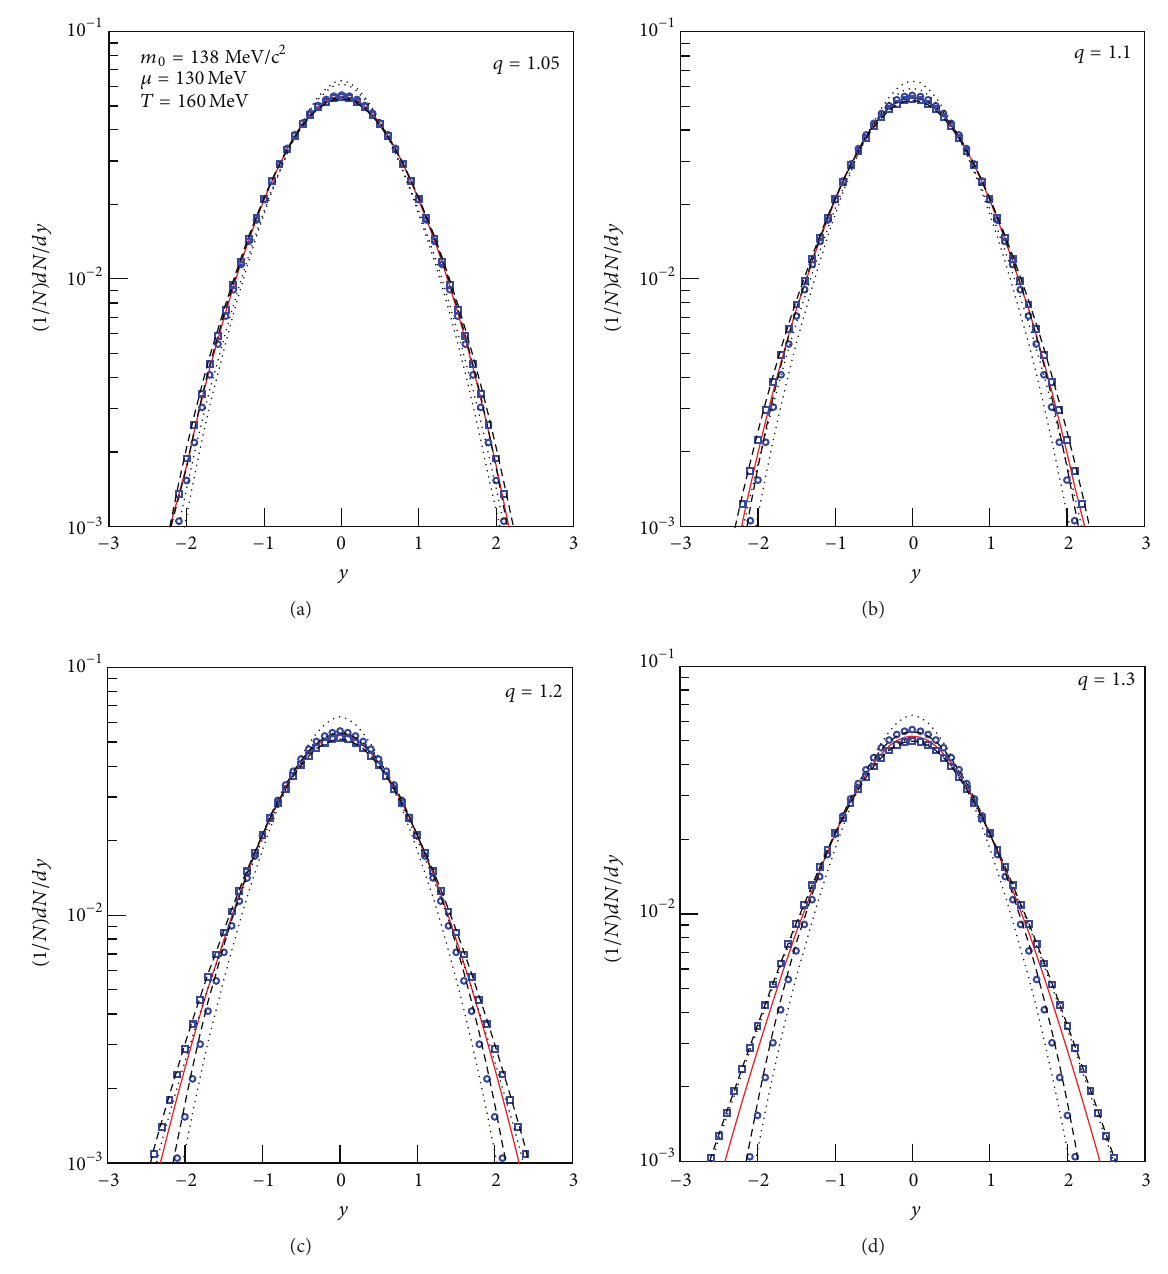
Figure 2: It is the same as for Figure 1, but it shows the rapidity